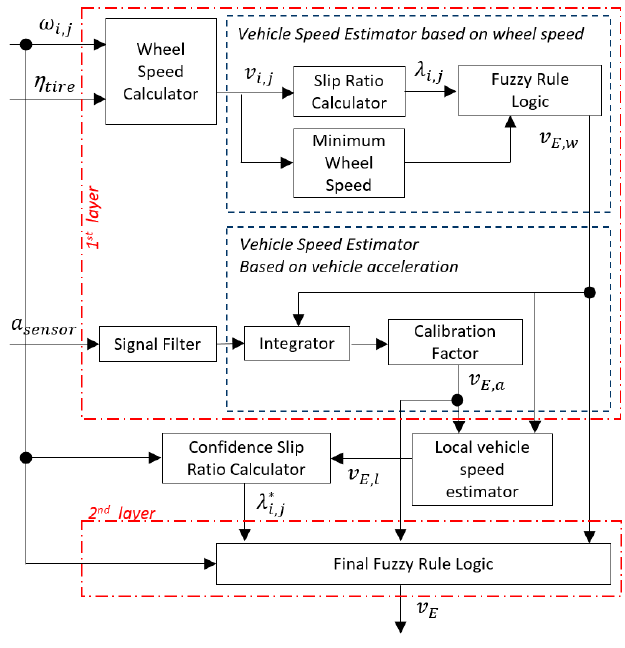
Figure 1. Estimator Strategy